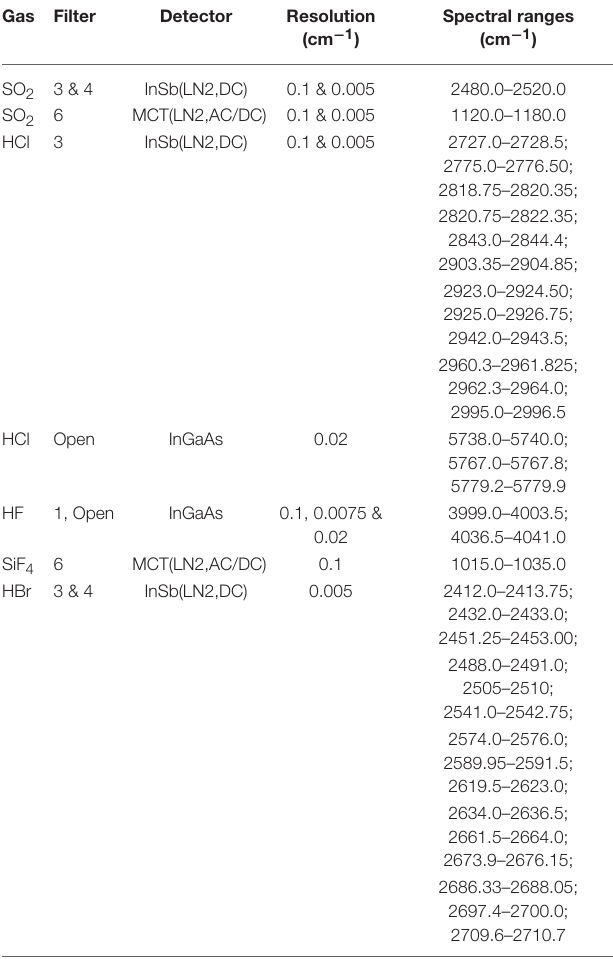
TABLE 1 | Filters, detectors, and spectroscopic parameters used for the analysis of SO 2 , HCl, HF, SiF 4 , and HBr in the Popocatépetl’s plume from solar absorption measurements (LN2 = liquid nitrogen